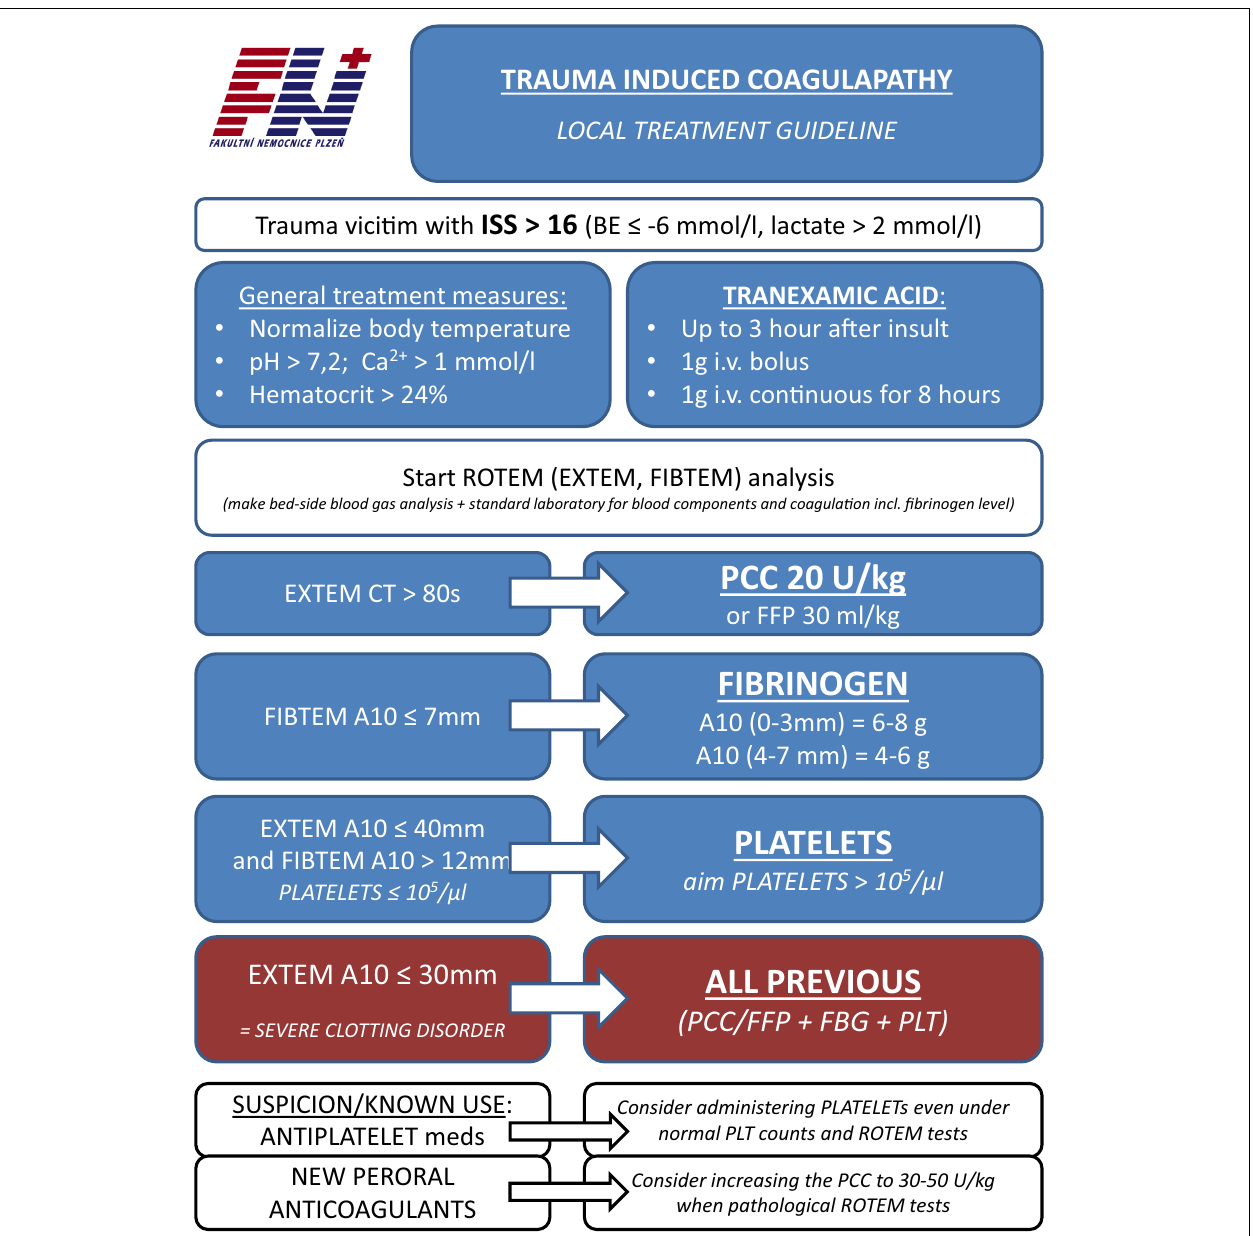
FIGURE 3 | The protocol of acute traumatic coagulopathy of the authors’ institution (English translation) .